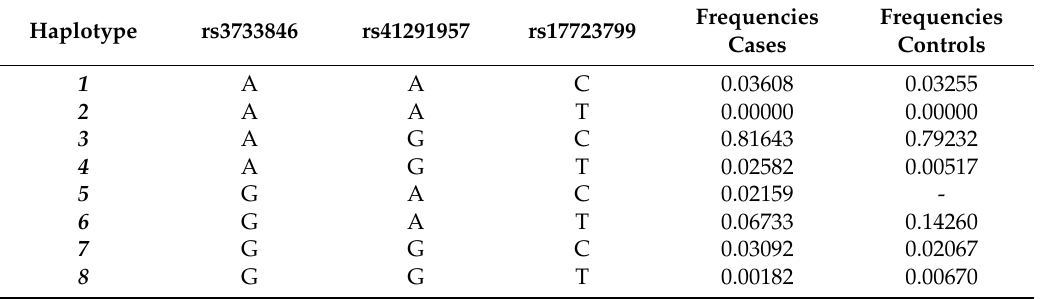
Table 9. Haplotype frequencies for analysed MIR143 SNPs in GLP-NHL case and control populations.